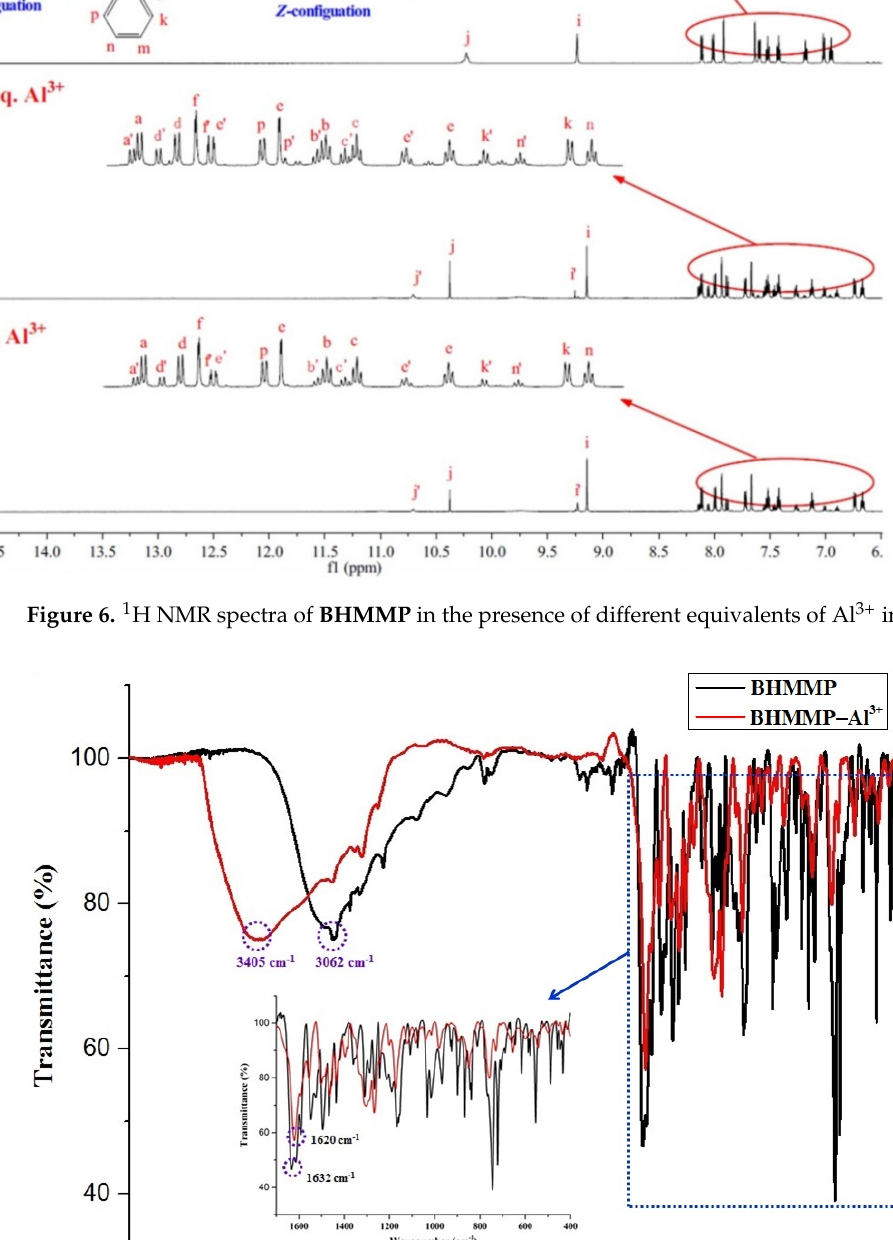
Figure 7. The FT-IR spectrum of BHMMP , compared to the BHMMP –Al 3+ complex.